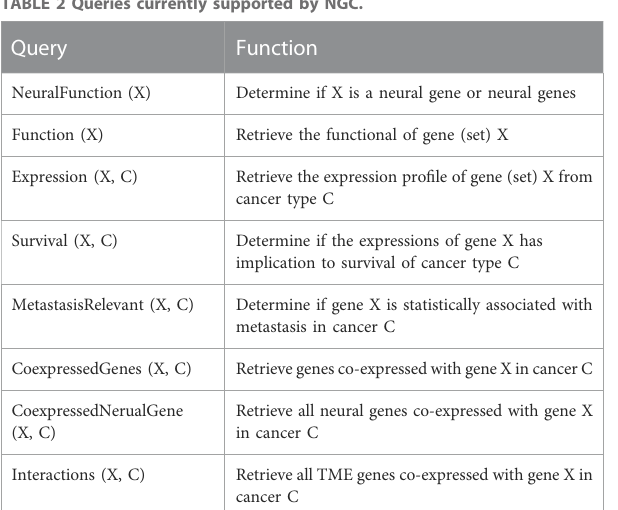
TABLE 2 Queries currently supported by NGC. TABLE 3 Analysis tools supported by